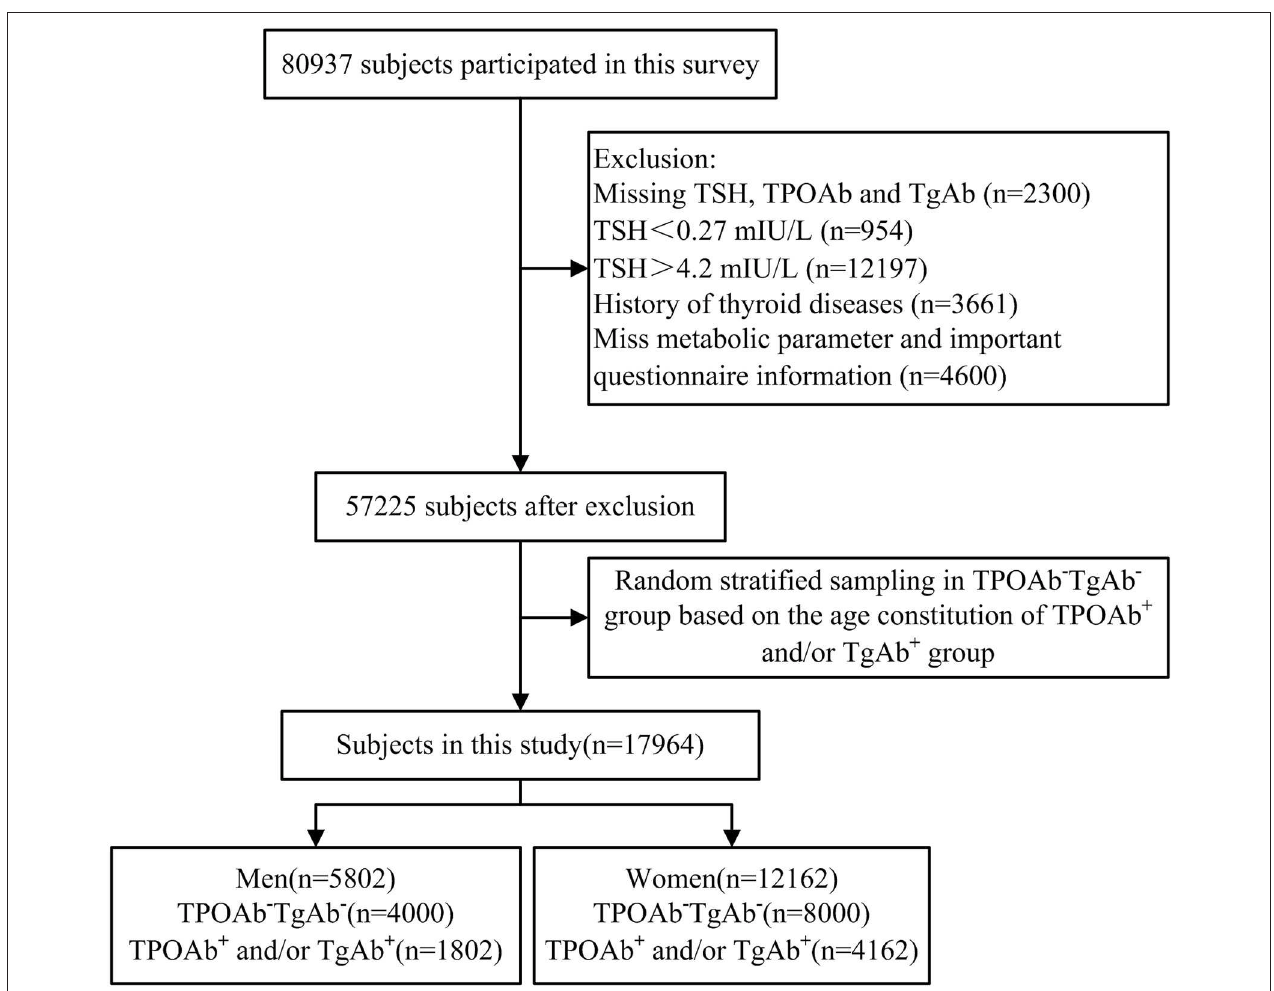
FIGURE 1 | Flowchart of the inclusion and exclusion of participants in this